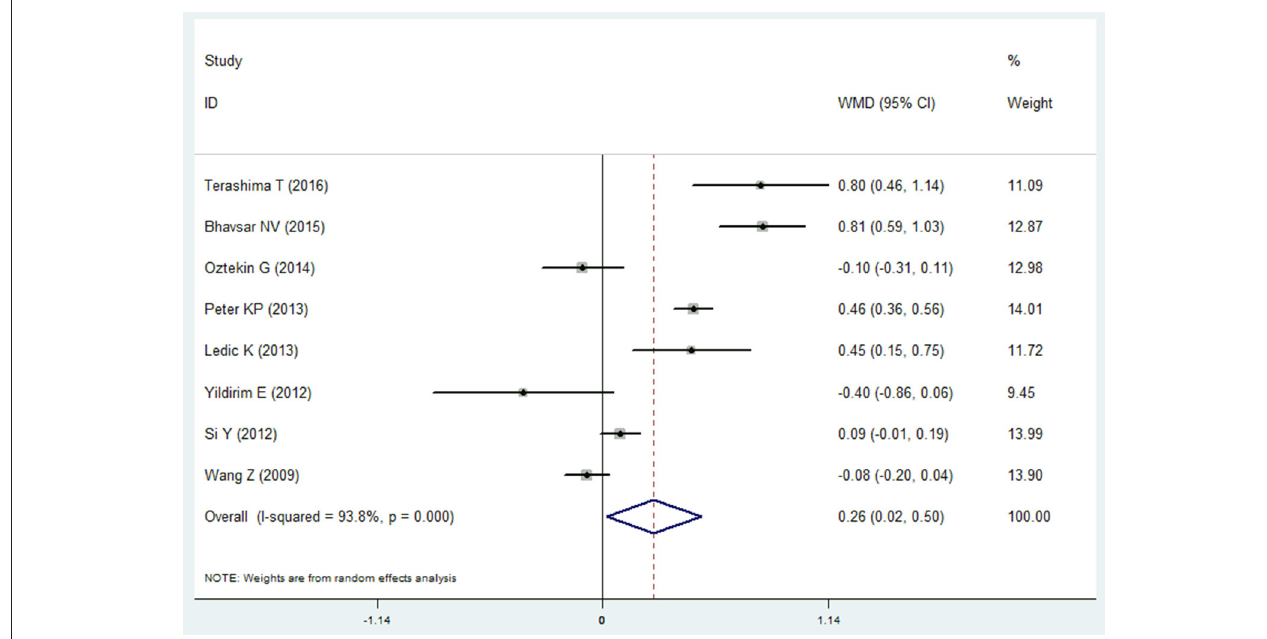
FIGURE 2 | Forest plot of the mean difference in probing depth between the COPD and non-COPD groups.